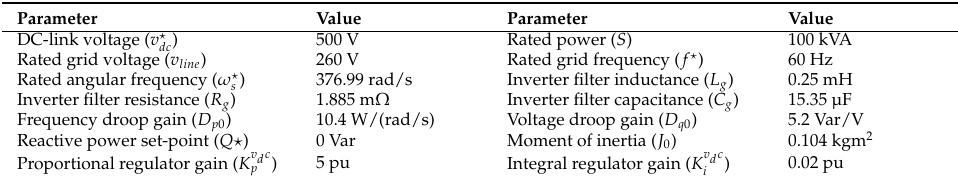
Figure 4. Grid-connected WTGS implemented with a synchronverter model Table 2. Parameters of the synchronverter.